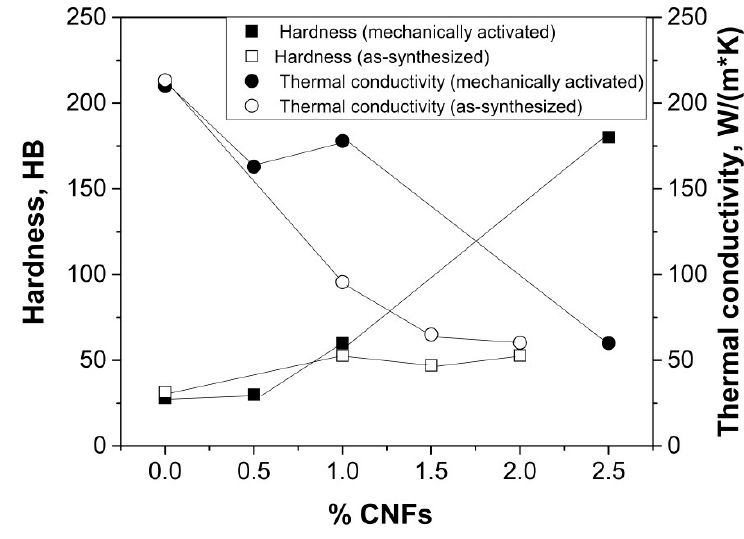
Figure 9. Hardness and thermal conductivity versus carbon content.